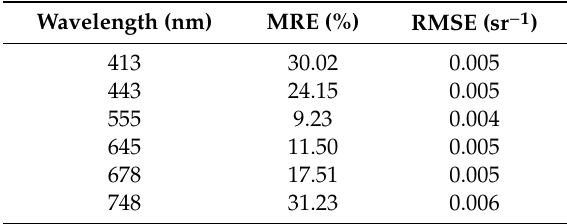
Table 6. Error statistics of R rs derived from the corrected